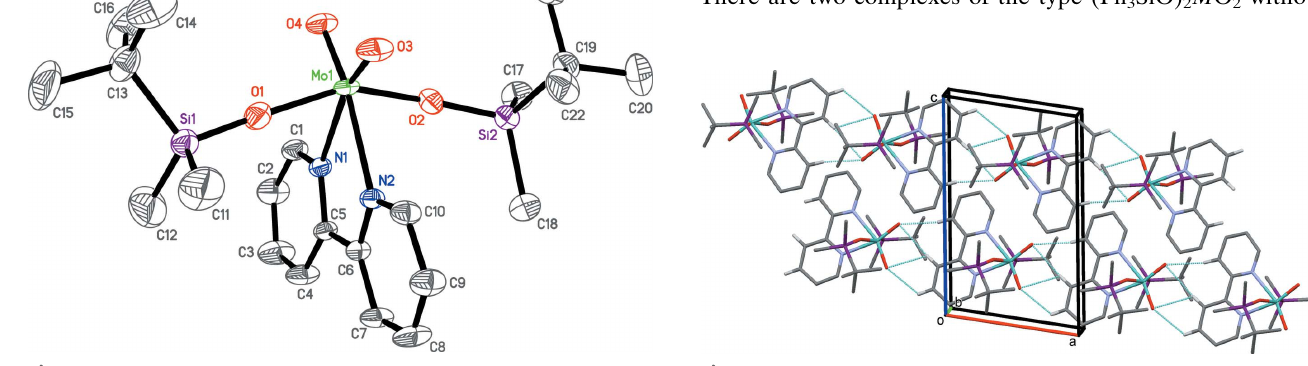
Figure 3 A view along the b axis of the crystal packing of the title complex (I). Only the H atoms involved in hydrogen bonding (dashed lines; see Table 2) are included.